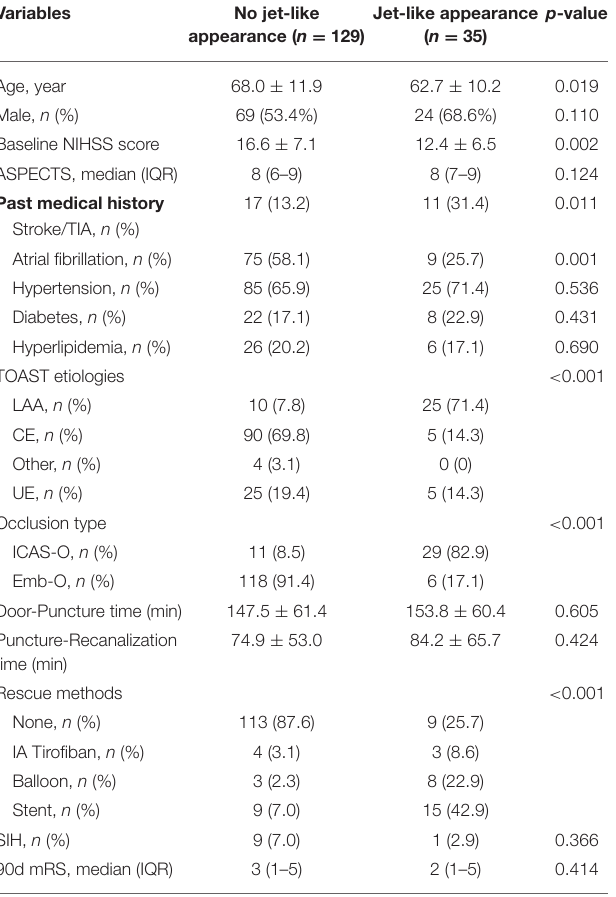
TABLE 1 | Comparison of baseline characteristics between patients with and without Jet-like appearance. Variables